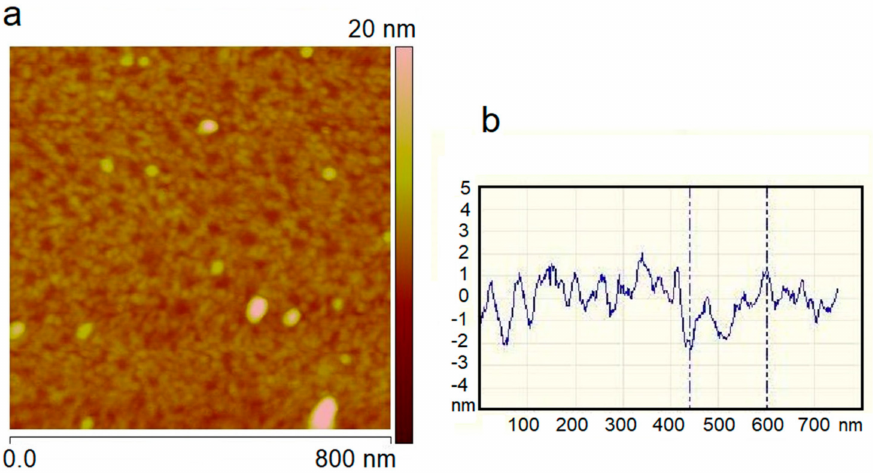
Figure 2. Atomic force microscope (AFM) results of the aryl grafted silicon surface after electrochemical reduction in the diazonium salt and sulfuric acid mixed solution (S 1 , Table 1): ( a ) Two-dimensional area scan and ( b ) the line profile showing vertical displacement versus